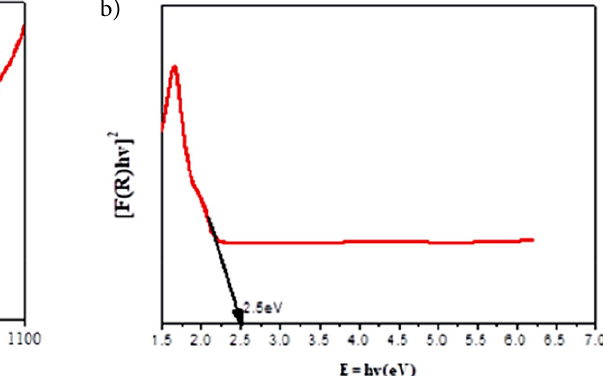
Figure 4. (a) DRS spectrum; (b) Energy band gap plot of Fe 2 O 3 NPs.